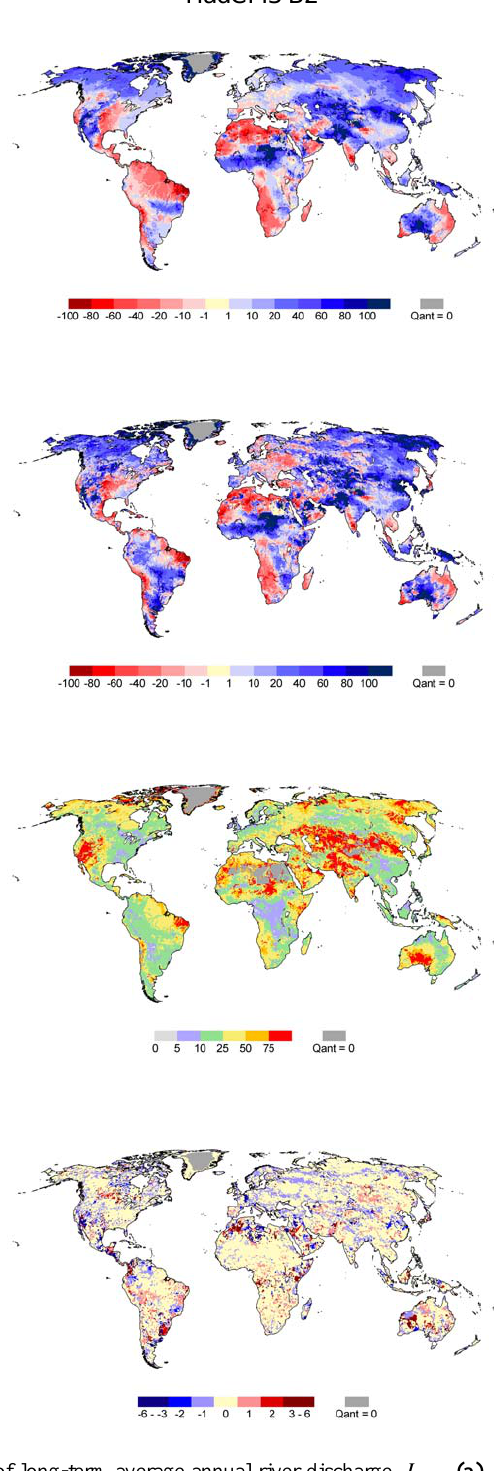
Fig. 2. Impact of climate change on river discharge: percent change of long-term average annual river discharge, I LTA (a) , seasonal flow amplitudes, I SA (b) , seasonal flow regimes, I SR (c) and shift of the month with maximum flow, I TS , in months (d) , between 1961–1990 and 2041–2070. Emissions scenario B2 as implemented by the global climate models ECHAM4 and HadCM3, river flows anthropogenically altered due to dams and water withdrawals of the year 2002 (CC-ANT – ANT, in % of ANT).